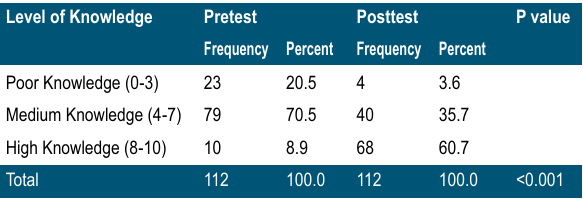
Table 3: Impact of Menstrual Educational Programme on Level of Knowledge regarding Menstrual